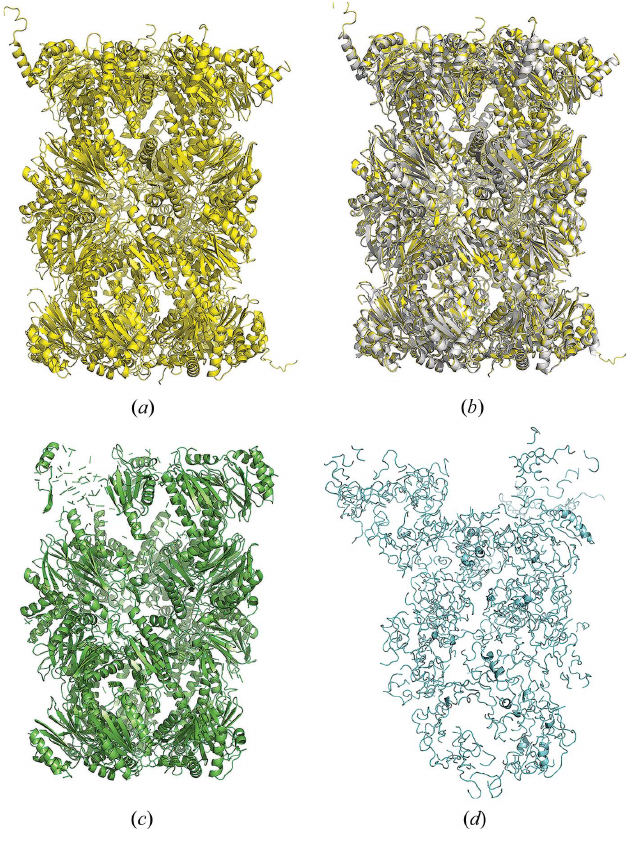
Figure 5 Method comparison, case study 3. ( a ) Model from IPCAS ; ( b ) model from IPCAS superimposed with the crystal structure (PDB entry 5cz4); ( c ) model from Phenix.AutoBuild ; ( d ) model from Buccaneer .